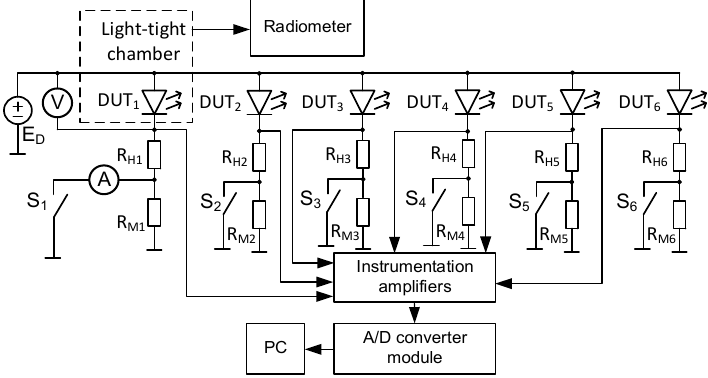
Figure 3. Diagram of the used measurement set-up.